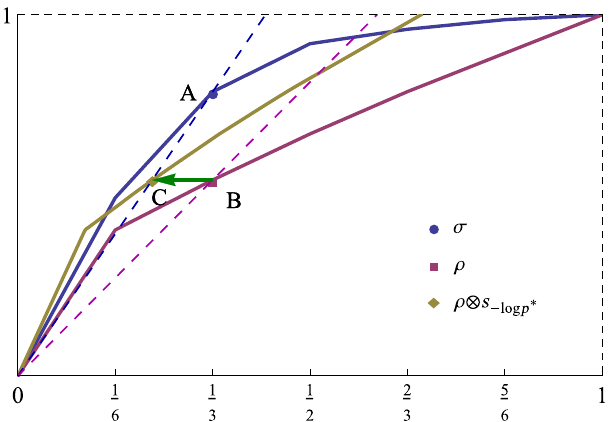
FIG. 2. We plot the curves of ρ , σ , and ρ compressed by p (cid:3) (with respect to the x axis). The points A and B at which the vertical ratio between the curves of ρ and σ is maximum (which sets l 1 and p (cid:3) ), and the sharp states that pass through those points, are also shown as dashed lines. After compressing the Lorenz curve of ρ by a ratio of p (cid:3) , the point B will be taken to C, which will always either be below the curve of σ or just touching it. This proves the lower bound in Eq. (33).